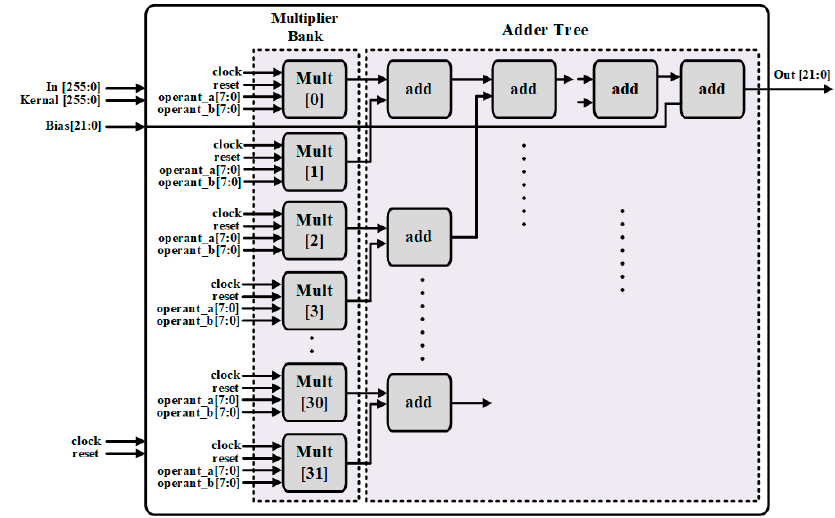
Figure 8. The architecture of convolutional operation.